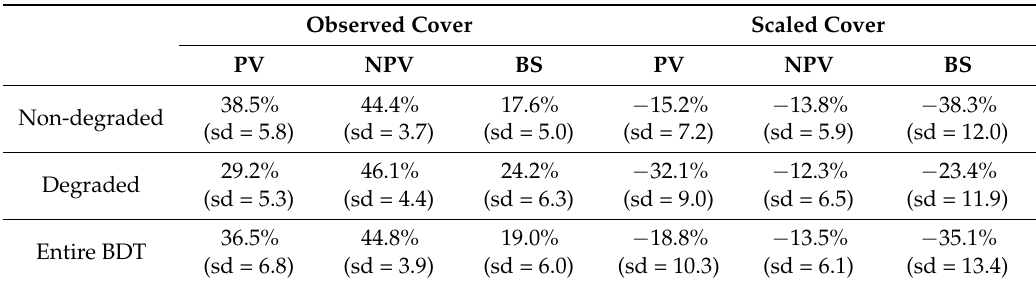
Table 2. Average of observed components of fractional cover, and their scaled counterparts, in the BDT for pixels assigned to either degraded or non-degraded NPP classes and for all pixels in the entire BDT. sd = standard